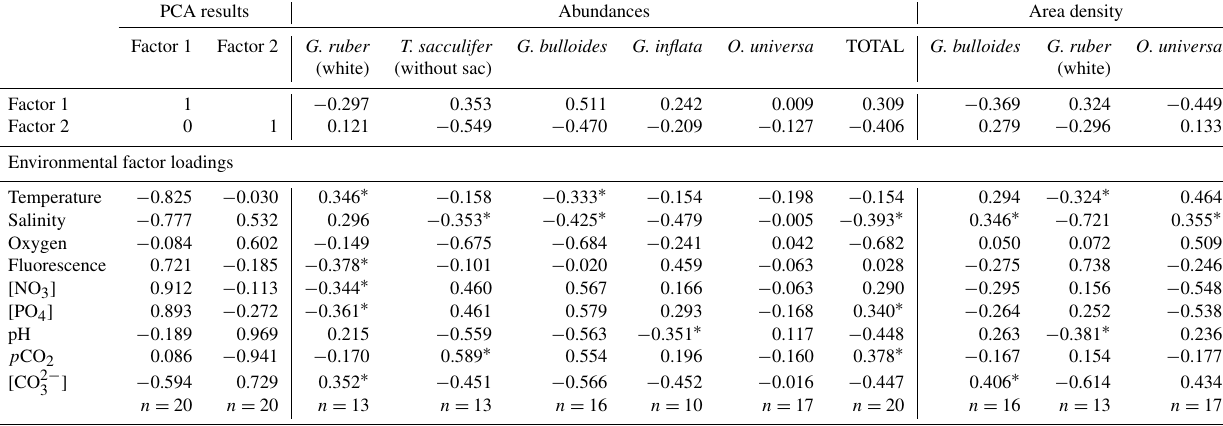
Table 2. Loadings of the environmental parameters in the PCA and additional Pearson correlation coefficients ( r) for relationships between other variables and PCA factors ( n = 20) and the results for the abundances of G. ruber (white) ( n = 13), T. sacculifer (without sac) ( n = 13), G. bulloides ( n = 16), G. inflata ( n = 10), O. universa ( n = 17), and the total abundances ( n = 20); and the area density of G. bulloides ( n = 16), G. ruber (white) ( n = 13), and O. universa ( n = 17). r values in bold are significant at p < 0 . 05, ∗ p < 0 .